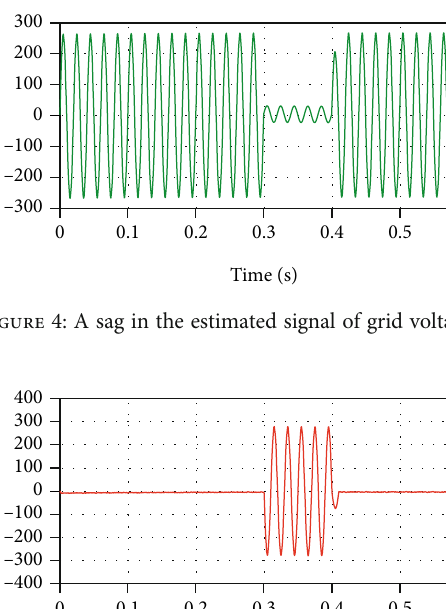
. (b) Zoom on these signals. 2